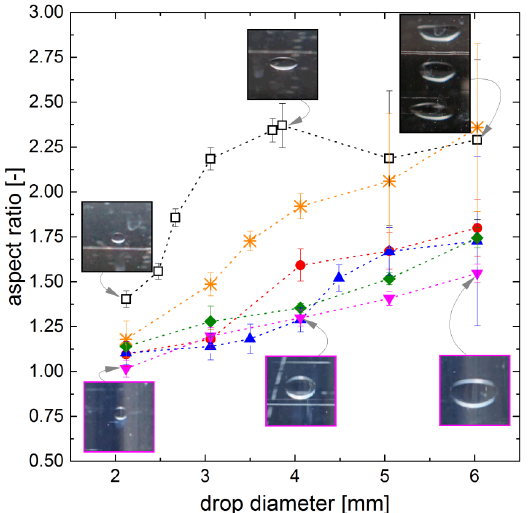
Figure 8. Deformation of drops displayed as aspect ratio (width to height ratio)(( ◻ pure system, ◆ MG1, ▾ MG2, ● MG3, ▴ MG4 and ∗ surfactant (SF)). Microgel-covered drops generated with 0.047mg / mL, surfactant data for c SF ≫ cmc , dotted lines as guide to the eyes.